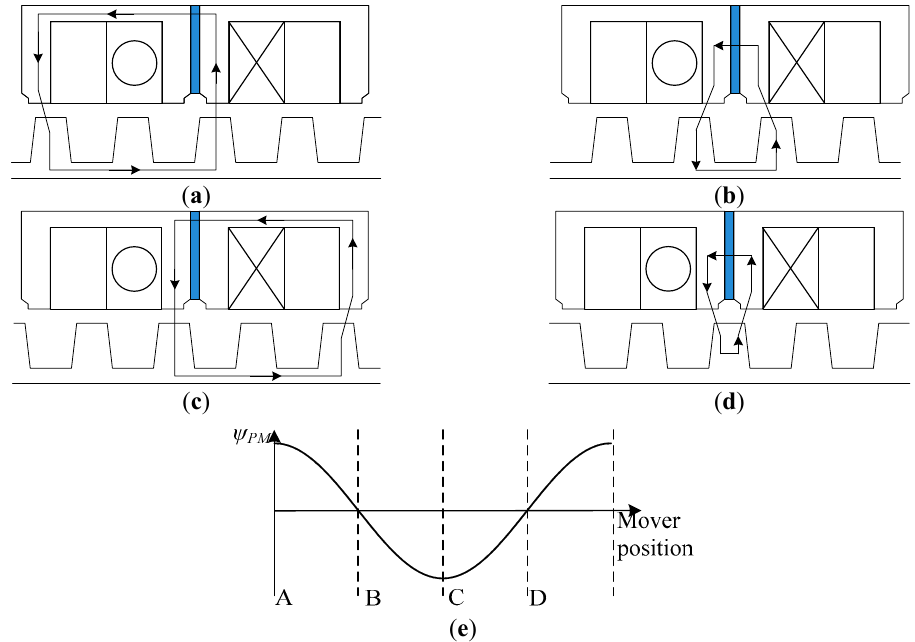
Figure 3. Operation principle of 6/13-pole C-core LFSPM machine. ( a ) Position A; ( b ) Position B; ( c ) Position C; ( d ) Position D; ( e ) Ideal coil PM flux linkage.